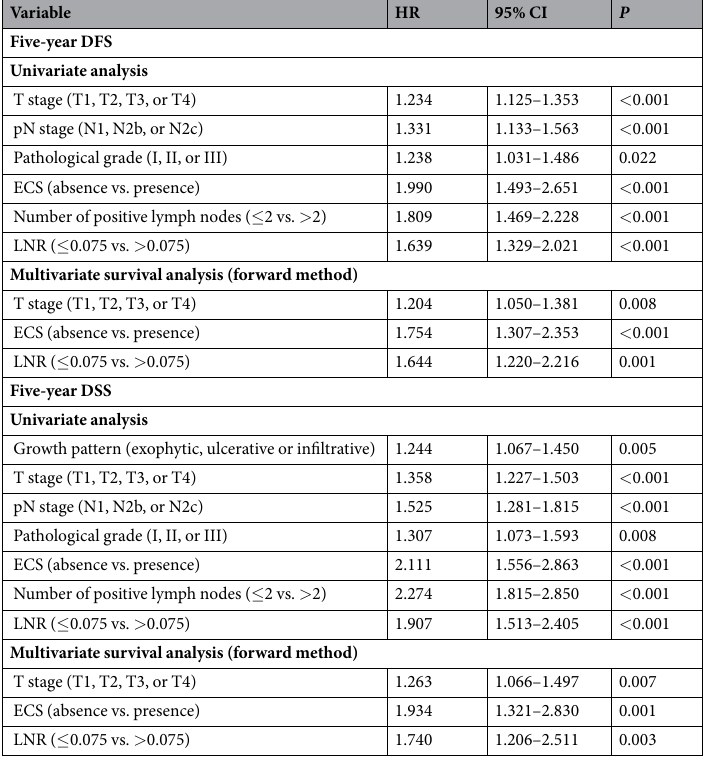
Table 2. Cox proportional hazards regression models estimating 5-year DFS and 5-year DSS. Notes: LNR, lymph node ratio; pN stage, pathological node stage; ECS, extracapsular spread; RT, radiotherapy; CCRT, concurrent